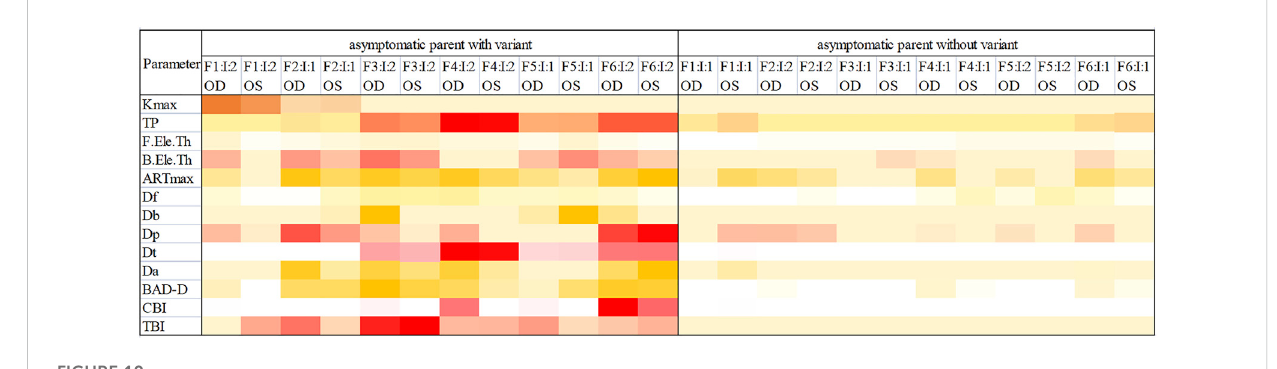
FIGURE 10 Heatmap ofparameters fromPentacamand Corvis STexaminations oftheparentsinthesix families. Darker colormeanstheindicator ismore likely to be abnormal. OD, right eye; OS, left